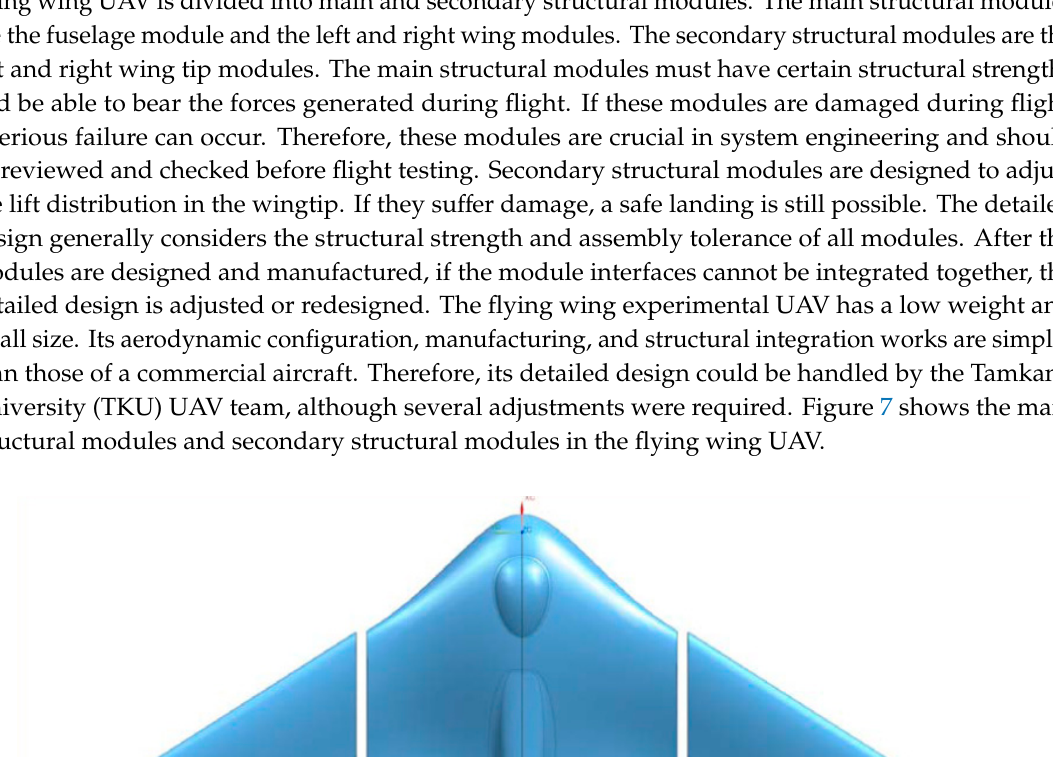
( b ) Figure 8. ( a ) Engineering drawing of ribs and ( b ) preassembly of ribs. The skin provides an impermeable surface for maintaining the air pressure distribution on the wing. It is made of composite materials, specifically, carbon fiber and epoxy resin composites that were fabricated using vacuum bagging and a hand lay-up method, to reduce the aircraft’s structural weight. The mold and ribs must be produced before fabricating the skins. Composite materials and medium-density fiberboard (MDF) molds are cheaper than aluminum or steel molds and were therefore designed and fabricated to make the skins of the flying wing UAV. The molds of composite materials consisted of Styrofoam, glass fiber, and epoxy resin. First, the